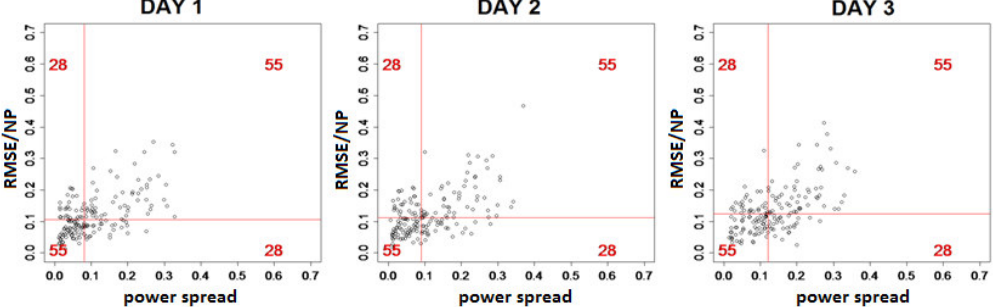
Figure 2. ECMWF deterministic power forecast error (RMSE / NP) vs. ensemble power spread computed as a daily average for three lead times. EPS T399 / T255 (60km). The lines are plotted at the statistical median value of the data reported in x- and y-axis. The red numbers indicate the points inside each quadrant (Day 1, 2 and 3 interval are explained in Table 2 caption).